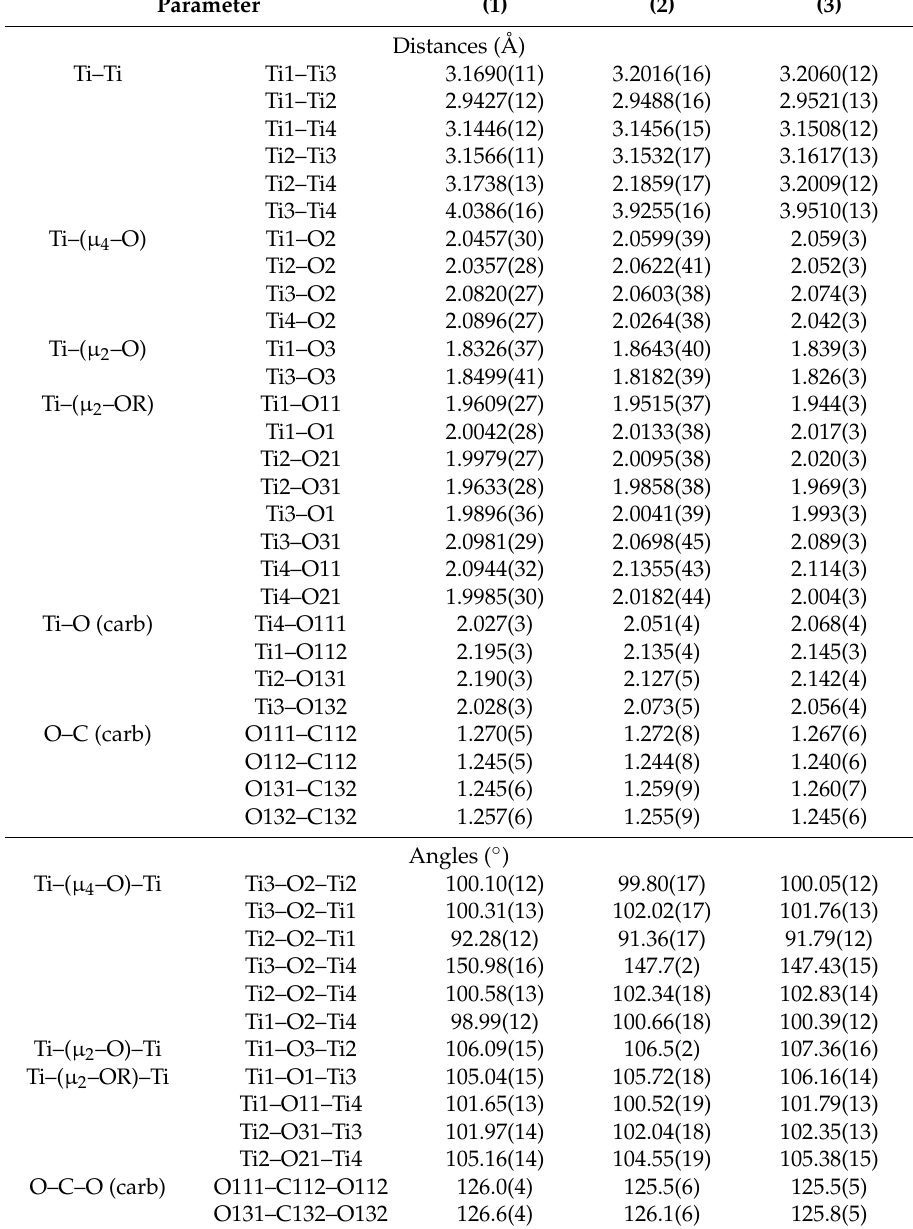
Table 2. Selected bond lengths (Å) and angles ( ◦ ) of (Ti 4 O 2 (O i Bu) 10 (O 2 CR’) 2 ) (R’ = C 13 H 9 ( 1 ), PhCl ( 2 ), PhNO 2 ( 3